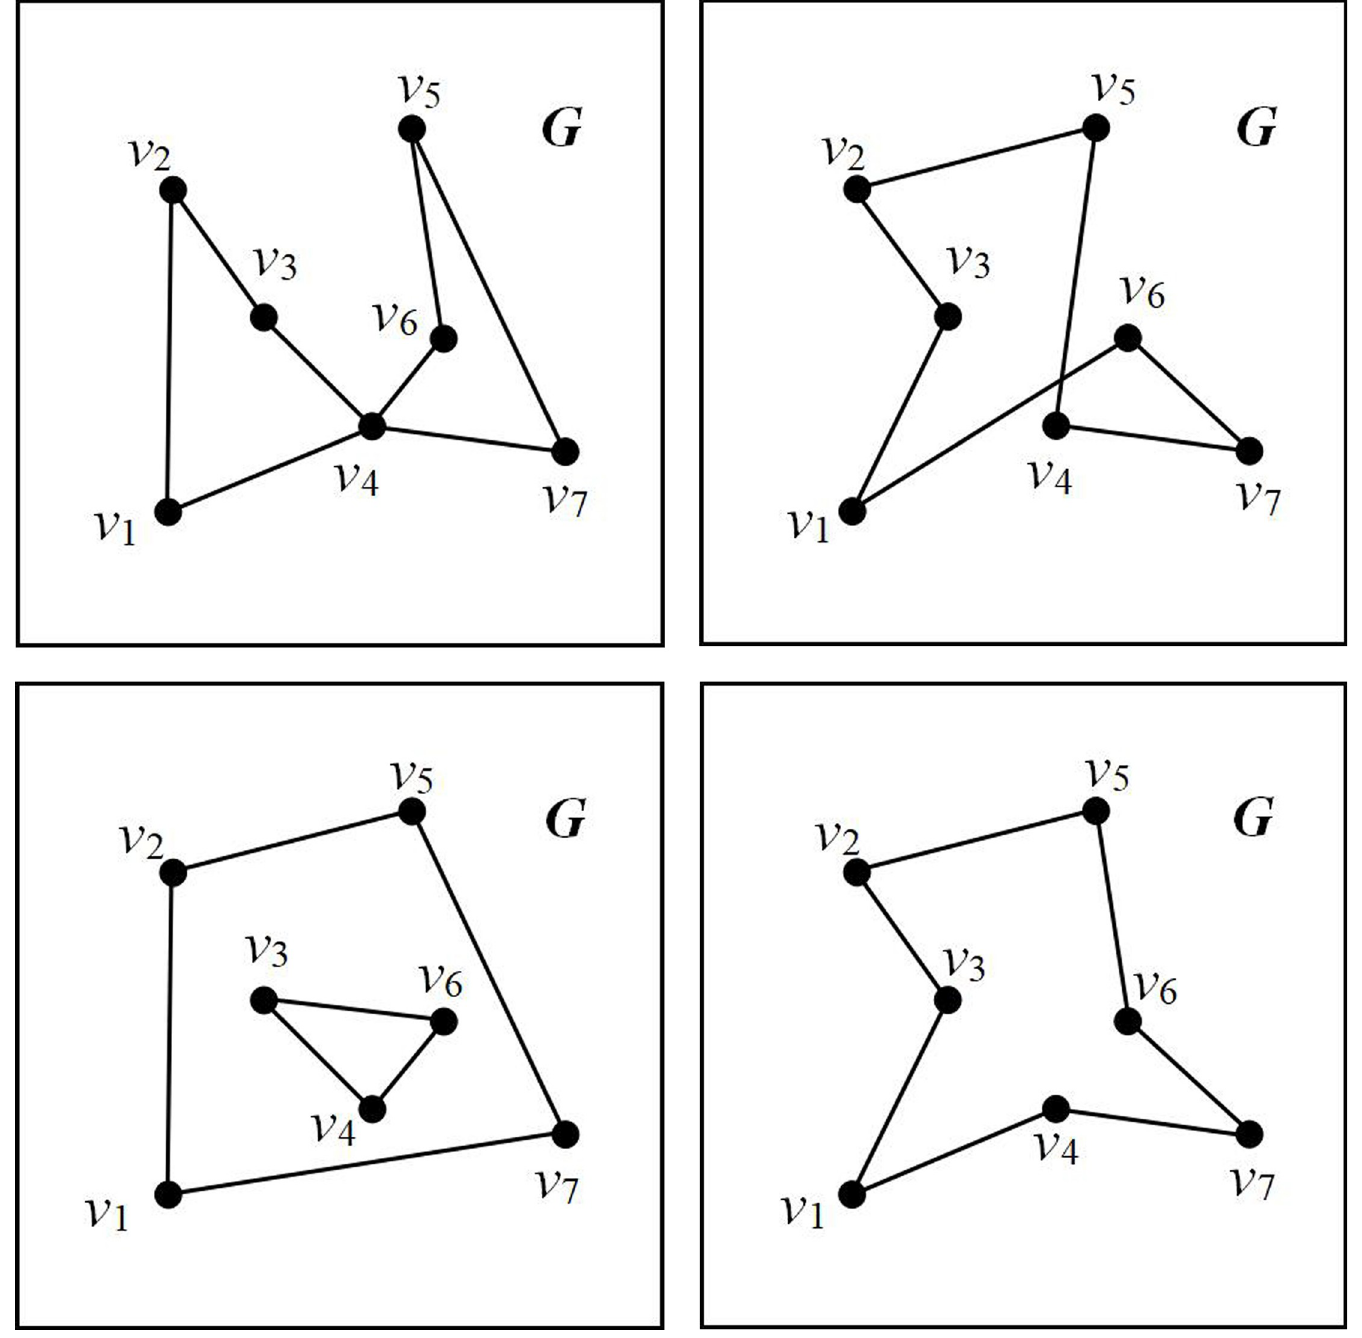
Fig 1. Various types of polygons. (a)-(d) Polygons with different geometries.